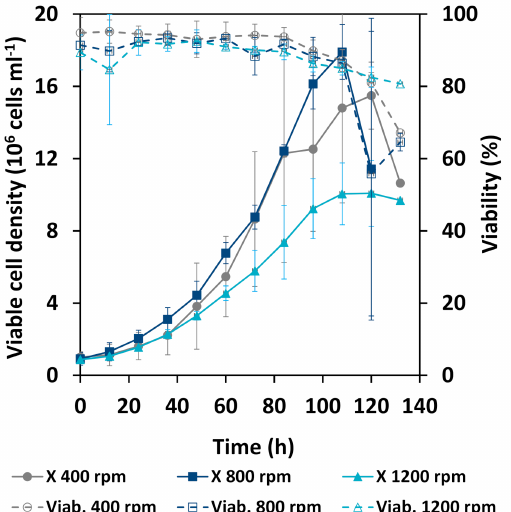
Figure 3. Mean growth curves (viable cell density X and viability) for the cultivations in the SIS at different agitation rates and respective averaged power inputs: 400 rpm (16 W m − 3 ); 800 rpm (110 W m − 3 ); 1200 rpm (356 W m − 3 ). Data were averaged from three cultivations